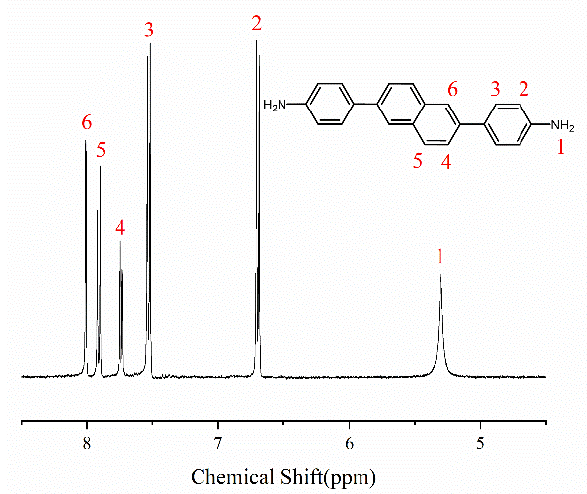
Figure 1. H NMR spectrum of NADA.